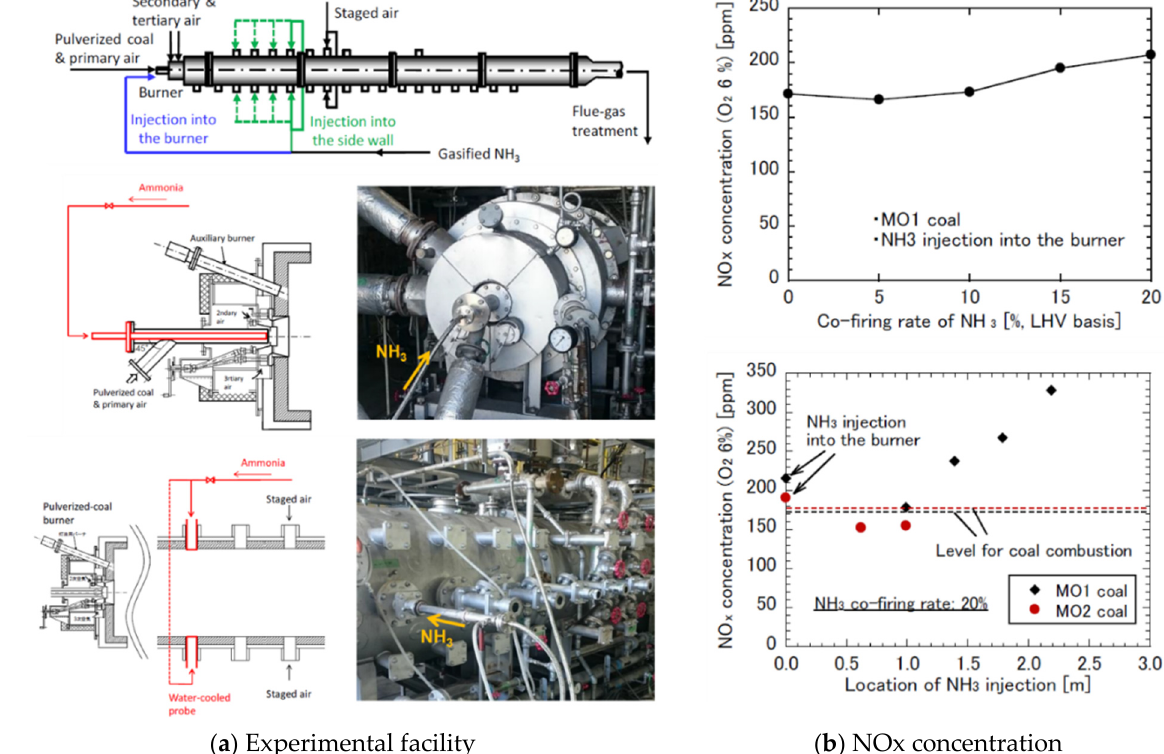
Figure 25. Horizontal pulverized coal furnace in CRIEPI: ( a ) Schematic of combustion system; ( b ) NOx concentration measured. Modified from [115]. Courtesy of Ammonia Energy Association [115].